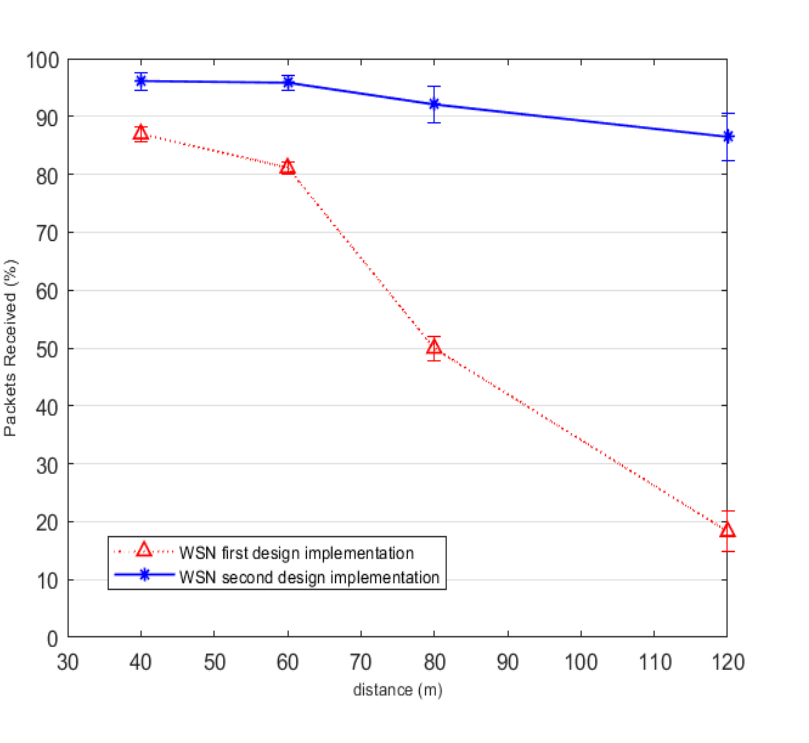
Figure 16. Performance evaluation and comparison between the first and second WSNs implemen- tations for non-line of sight area with observable obstacles depicting ( a ) RSSI, ( b ) Packets received percentage.